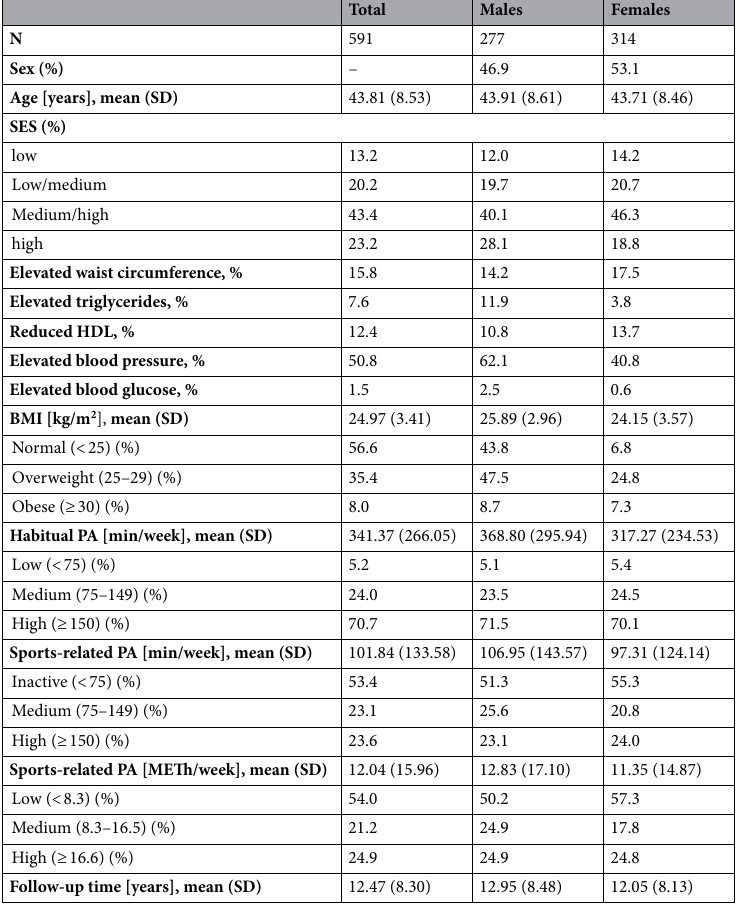
Table 1. Participant demographics at baseline. BMI body mass index, kg kilograms, m meters, METh metabolic equivalent hours, min minutes, N number of participants, PA physical activity, SD standard deviation, SES socio-economic status. Elevated waist circumference: ≥ 102 cm for males, ≥ 88 cm for females; elevated triglycerides: ≥ 150 mg/dL and/or specific medication; reduced HDL-cholesterols: < 40 mg/dL for males, < 50 mg/dL for females and/or specific medication; elevated blood pressure: systolic value ≥ 130 mmHg or diastolic value ≥ 85 mmHg and/or specific medication; elevated blood glucose: fasting